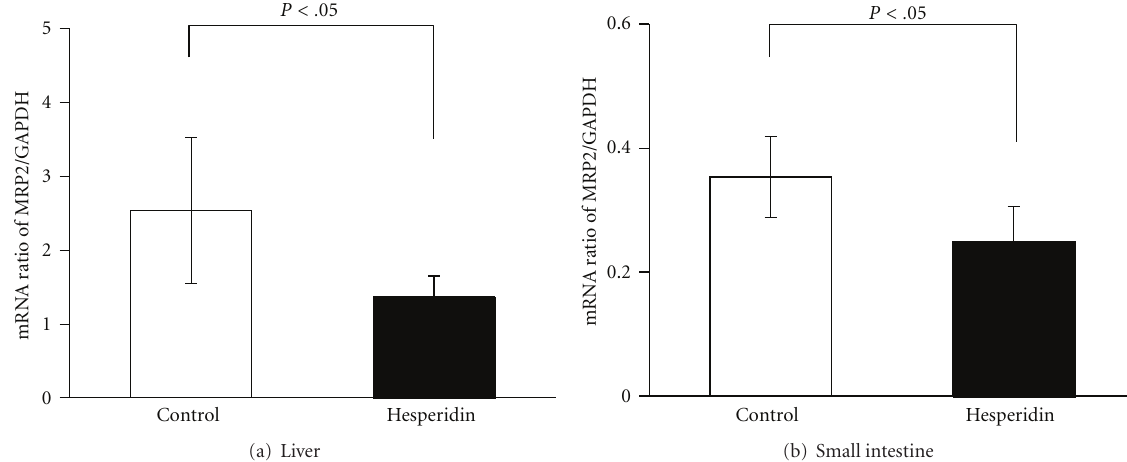
Figure 6: E ff ects of hesperidin on the expression of Mrp2 mRNA in both the liver (a) and small intestine (b) in rats. Determination of Mrp2 mRNA was performed using the same methods as in the in vitro OJ